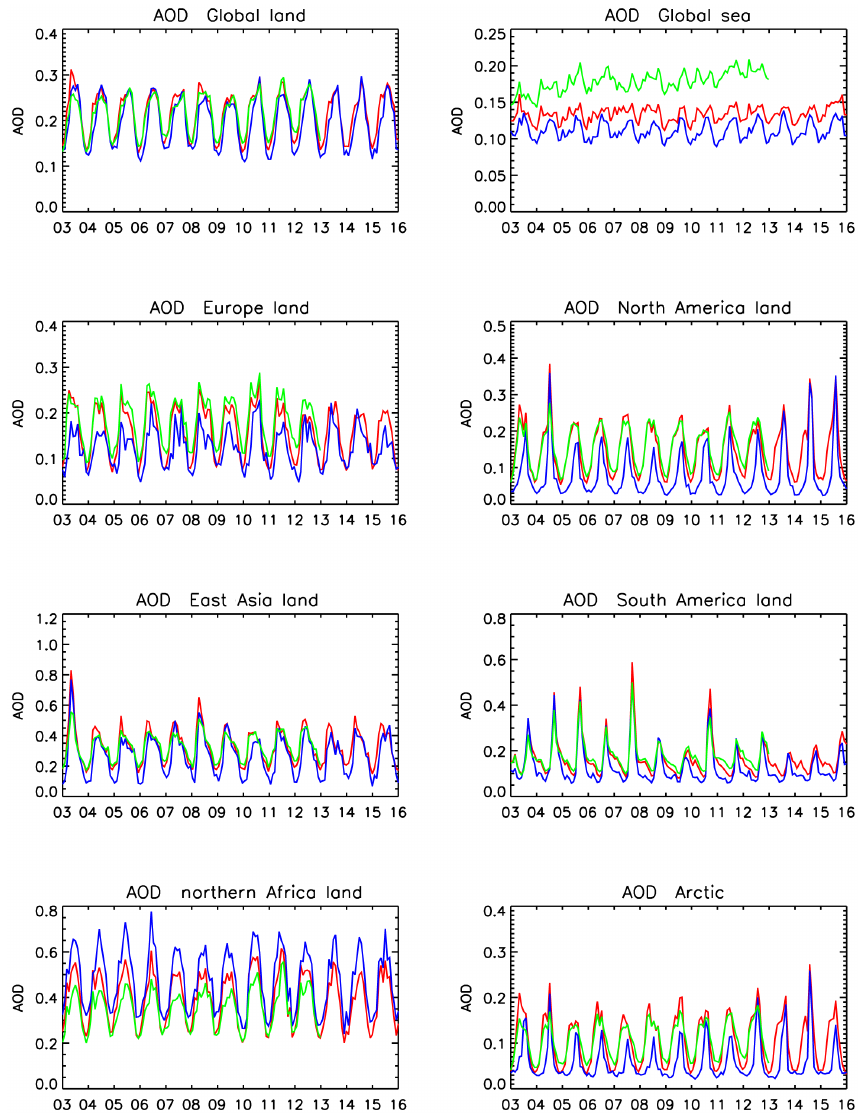
Figure 10. Time series of monthly mean AOD over the whole globe (land or sea points) and for different regions (see Table 3) for the period 2003–2015 from CAMSiRA (red), the CR (blue) and MACCRA (green,